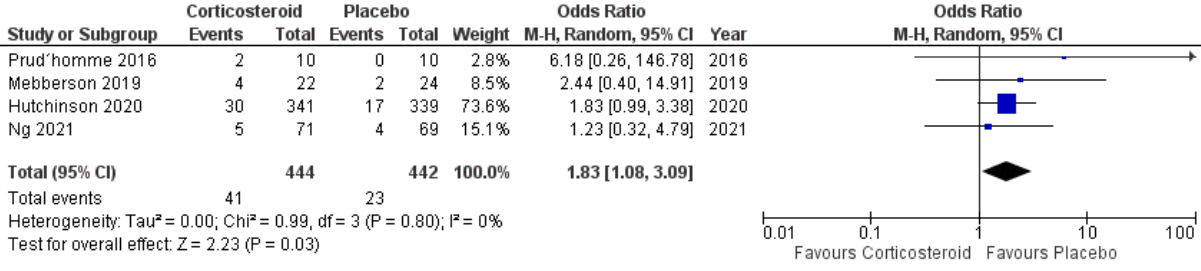
Figure 10 . Forest Plots displaying OR and 95% CI estimates for mortality in studies [28 – 30,32] evaluating anti-inflammatory therapies compared to placebo in patients with cSDH. Squares represent the odds ratio; the bigger the square, the greater the weight given because of the narrower 95% CI. Diamond represents the odds ratio of the overall